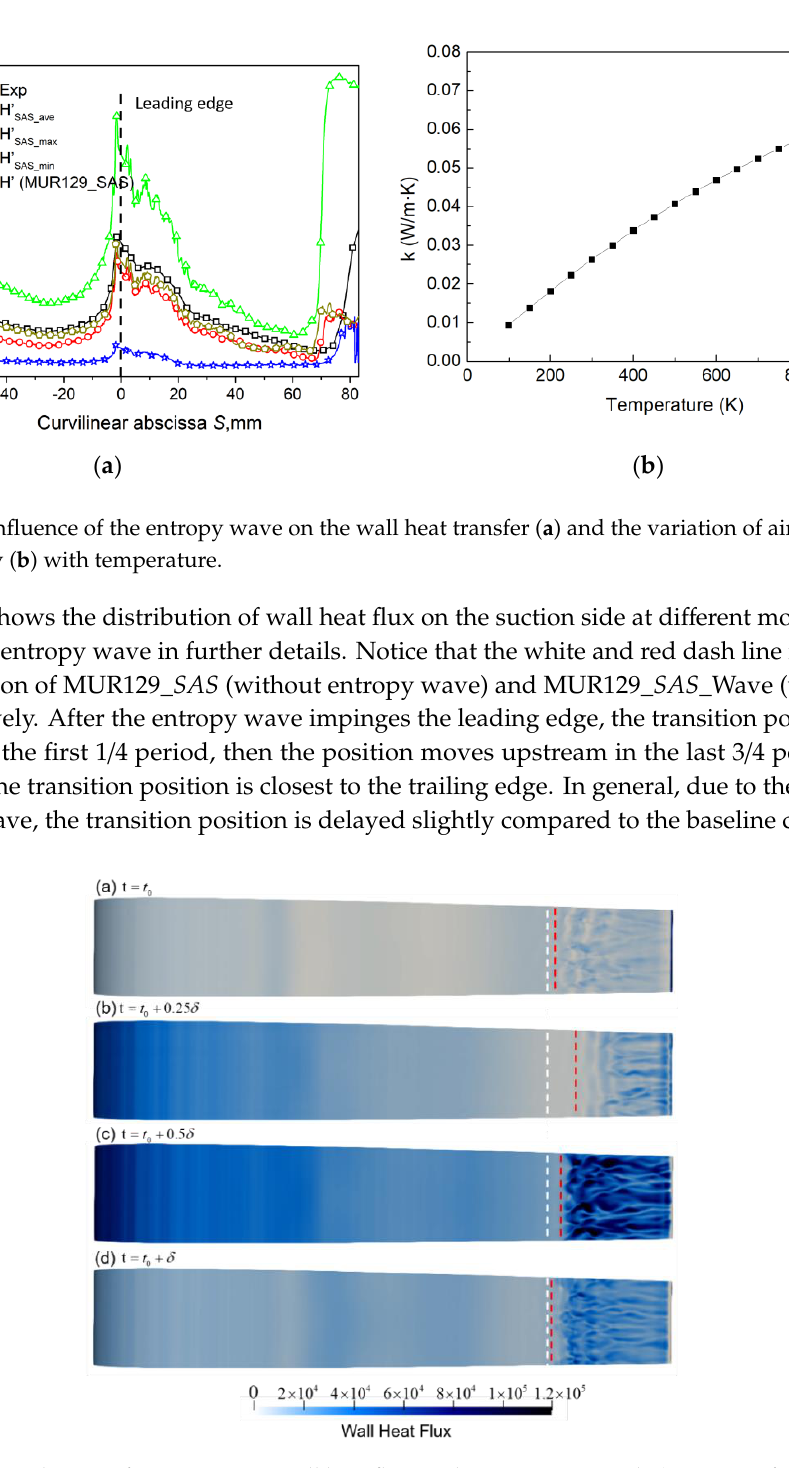
Figure 11. Distribution of instantaneous wall heat flux on the vane suction side (top view of the vane).